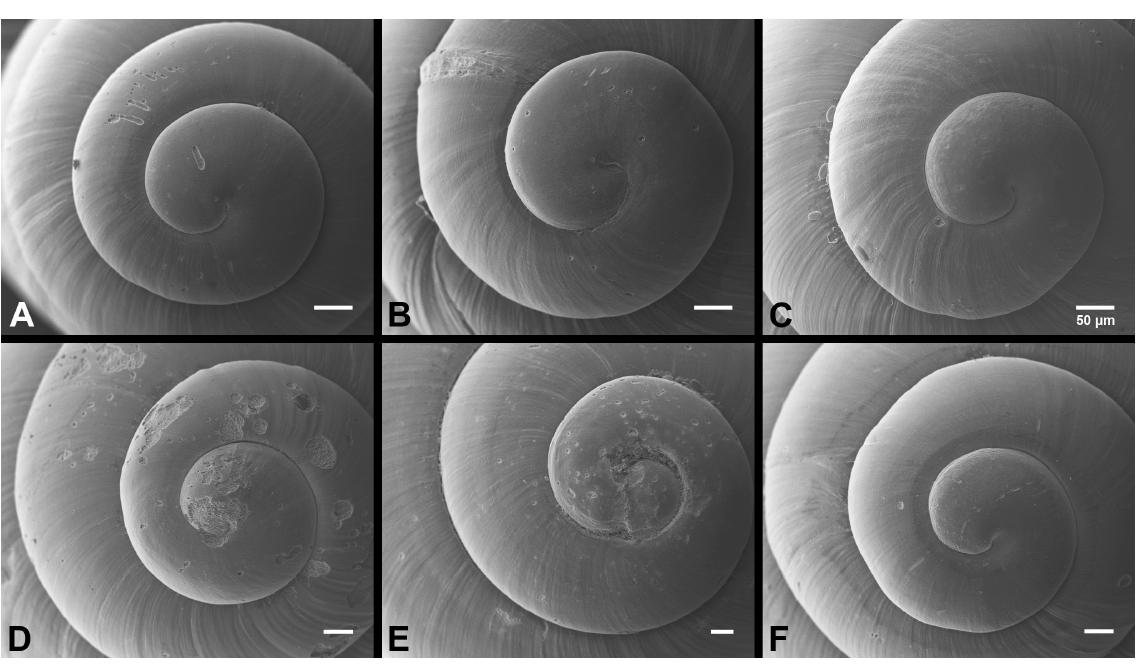
Fig. 6. Protoconch. SEM photographs of paratypes. A . Catapyrgus jami sp. nov. B – C . Opacuincola lisannea sp. nov. (B, topotype; C, northern locality). D . Op. gretathunbergae sp. nov. E . Op. mete kahurangi subsp. nov. F . Obtusopyrgus farri sp.